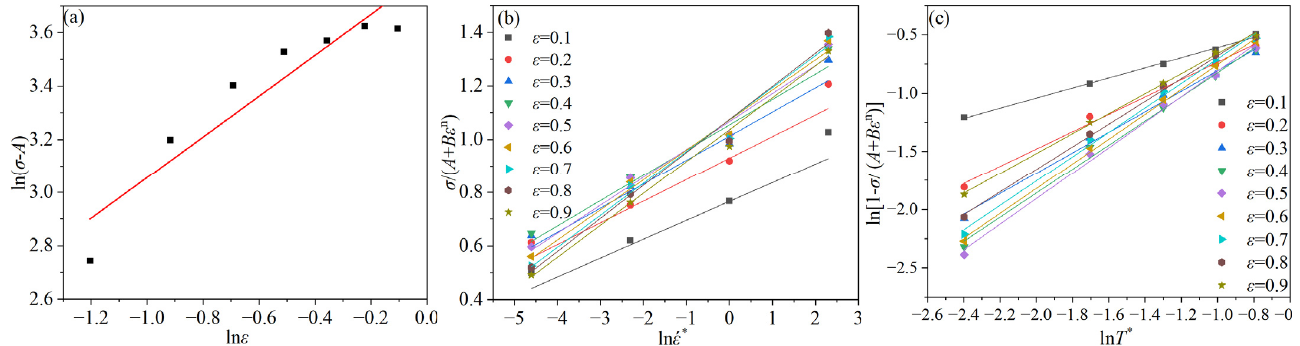
Figure 3. Relationship between: ( a ) ln ε and ln( σ − A ) at 1123 K and 1 s - 1 ; ( b ) σ / (cid:4666) A+B ε n (cid:4667) and ln ε (cid:4662) * at 1123 K; ( c ) ln (cid:4670) 1 - σ / (cid:4666) A+B ε n (cid:4667)(cid:4671) and ln T *